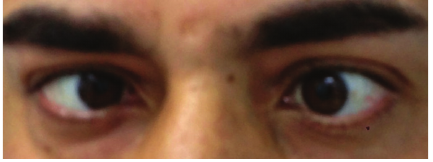
Figure 1: Photo of the patient at admission. Note the absence of motility of the left eye in the lateral gaze related to the deficit of the left lateral rectus muscle for abducens nerve